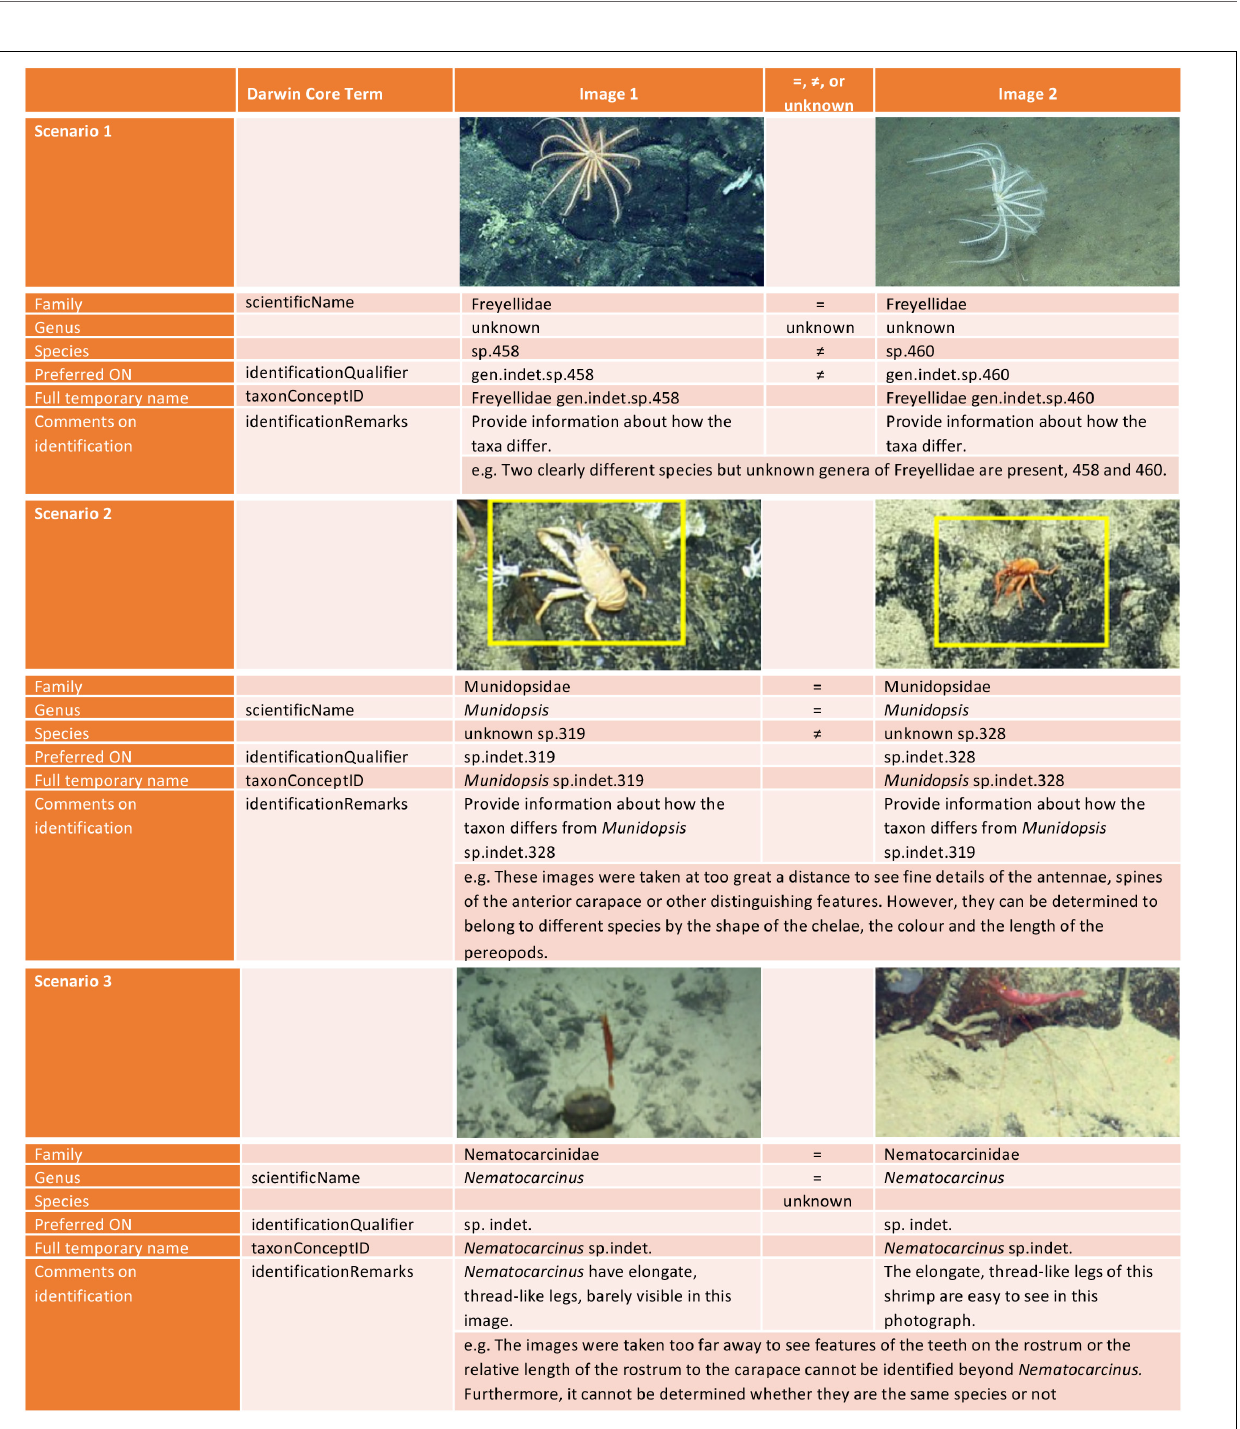
FIGURE 3 | Examples of more diffcult scenarios encountered in deciding on an image-based identification, and how to format the identification for input to online databases in Darwin Core format. Example scenarios are for two taxa indicating where identification at the taxonomic levels of family, genus, and species, are the same ‘=,’ different ‘ (cid:54)= ’ or if this information is unknown. Scenario 1 taxa are reproduced from Buglass et al. (2019). Scenario 2 and 3 images are from Arnés-Urgellés et al.